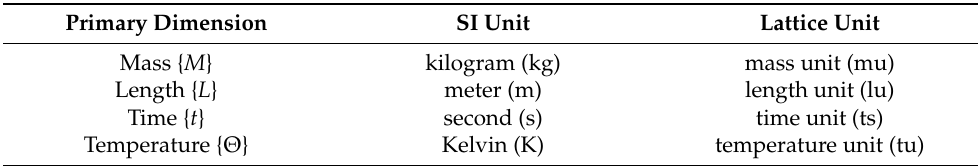
Table 1. Primary dimensions in SI and lattice system units. Primary Dimension SI